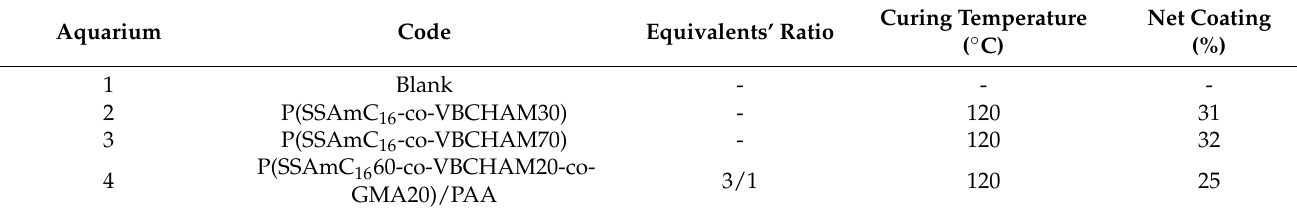
Table 2. Aquaculture nets, blank and coated with antimicrobial polymeric